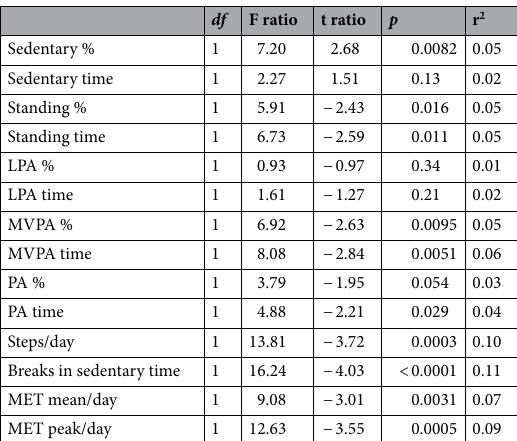
df F ratio t ratio